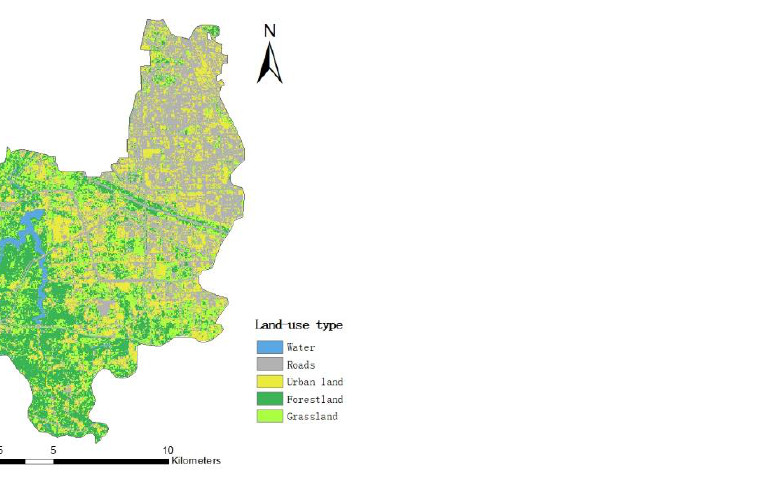
Figure 3. Land Use Types in Erqi District of Zhengzhou City. Table 1. Supervision Classification Calculation Results.